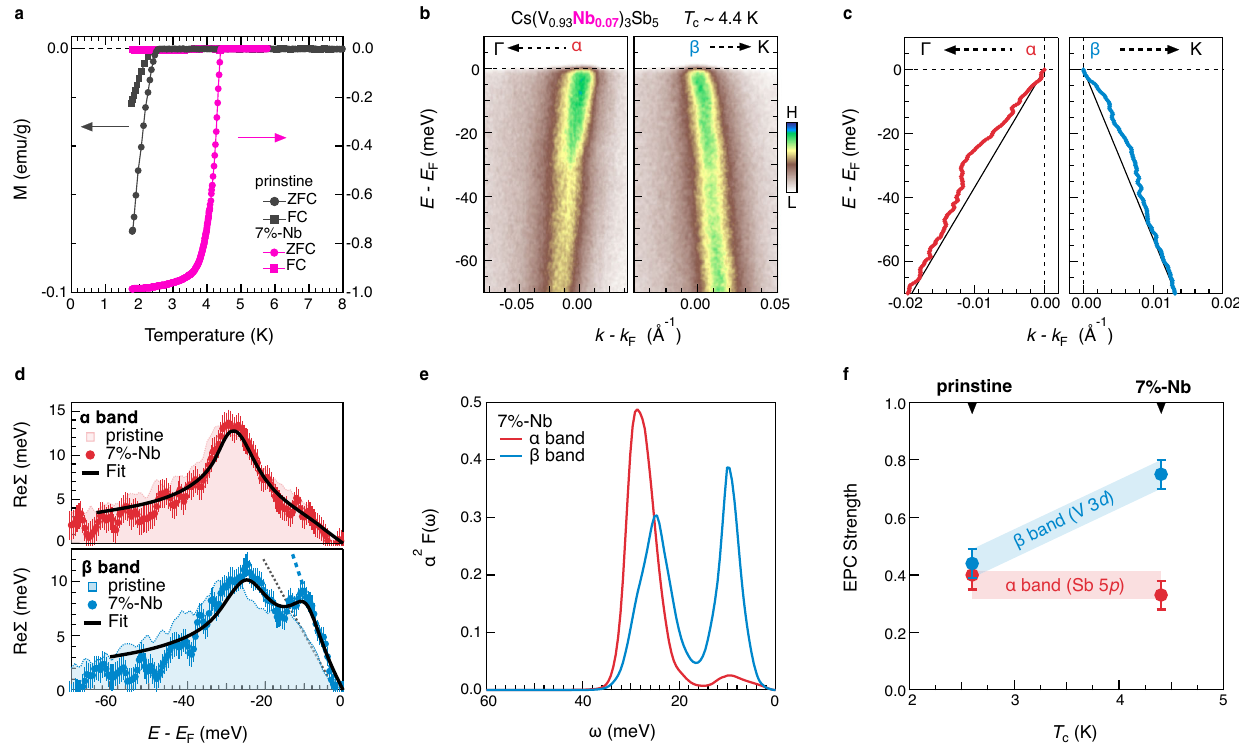
Fig.4|OrbitalandenergyselectiveenhancementofEPCinCs(V 0.93 Nb 0.07 ) 3 Sb 5 . a Temperature dependence of magnetic susceptibility for pristine CsV 3 Sb 5 and Cs(V 0.93 Nb 0.07 ) 3 Sb 5 . Both zero- fi eld cooling (ZFC) and fi eld cooling (FC) curves are presented. b ARPESintensityplotsofthe α and β bandsalongthe Γ − Κ directionfor Cs(V 0.93 Nb 0.07 ) 3 Sb 5 . The false color is adjusted for better visualization. c Extracted band dispersions for the α and β bands shown in ( b ). The black lines are the corresponding bare bands. d Extracted Re Σ ( ω )forthe α (top panel)and β (bottom panel) bands. The error bars for Re Σ ( ω ) are determined from the standard